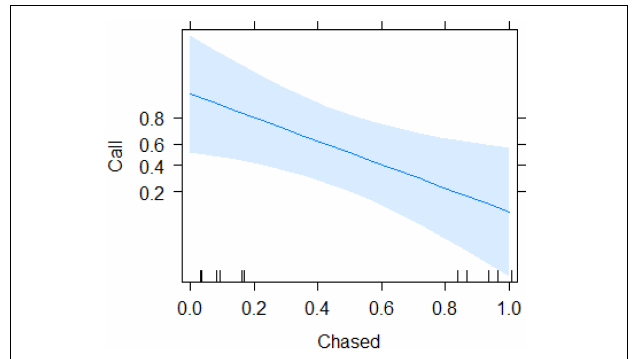
FIGURE 3 | Probability of call production by the subject as a function of whether it was chased or